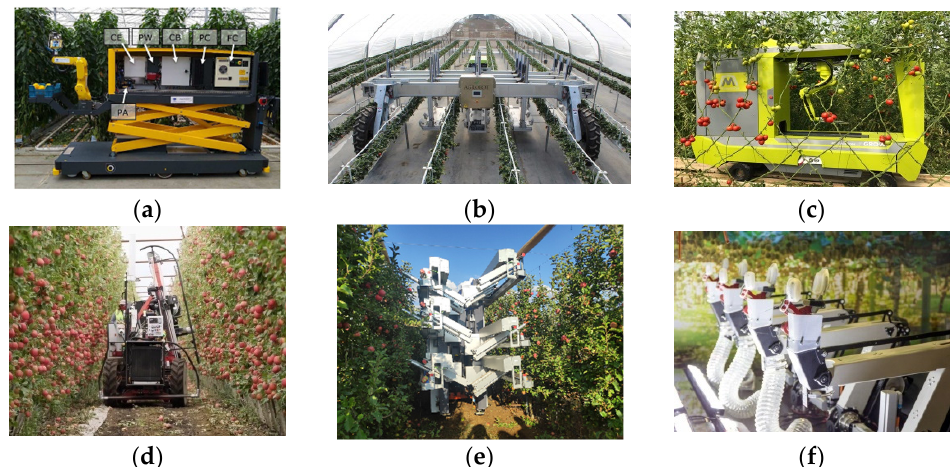
Figure 1. Typical harvesting robots. ( a ) Sweet pepper harvesting robot (Photo: Reprinted with permission from Ref. [10]. 2020, Arad B.); ( b ) strawberry harvesting robot (Photo: Reprinted with permission from Ref. [16]. 2019, Zitter L.); ( c ) tomato harvesting robot (Photo: Reprinted with permission from Ref. [17]. 2019, Leichman A.K.); ( d ) apple harvesting robot (Photo: Reprinted with permission from Ref. [15]. 2019, Thorne J.); ( e ) apple harvesting robot (Photo: Reprinted with permission from Ref. [20]. 2017, Dininny S.); ( f ) kiwi harvesting robot (Photo: Reprinted with permission from Ref. [18]. 2021, Saunders S.).